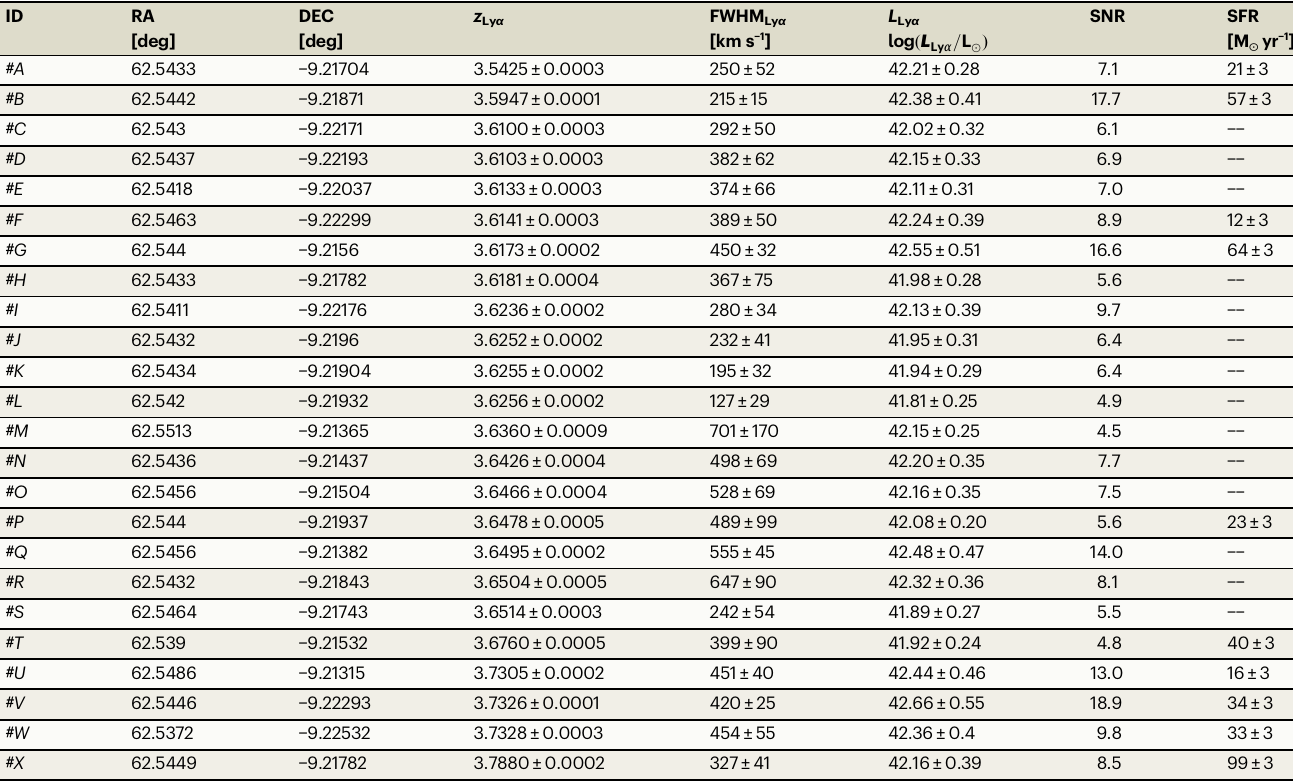
Table 1 | Measured properties of the Lyman- α emitters in the